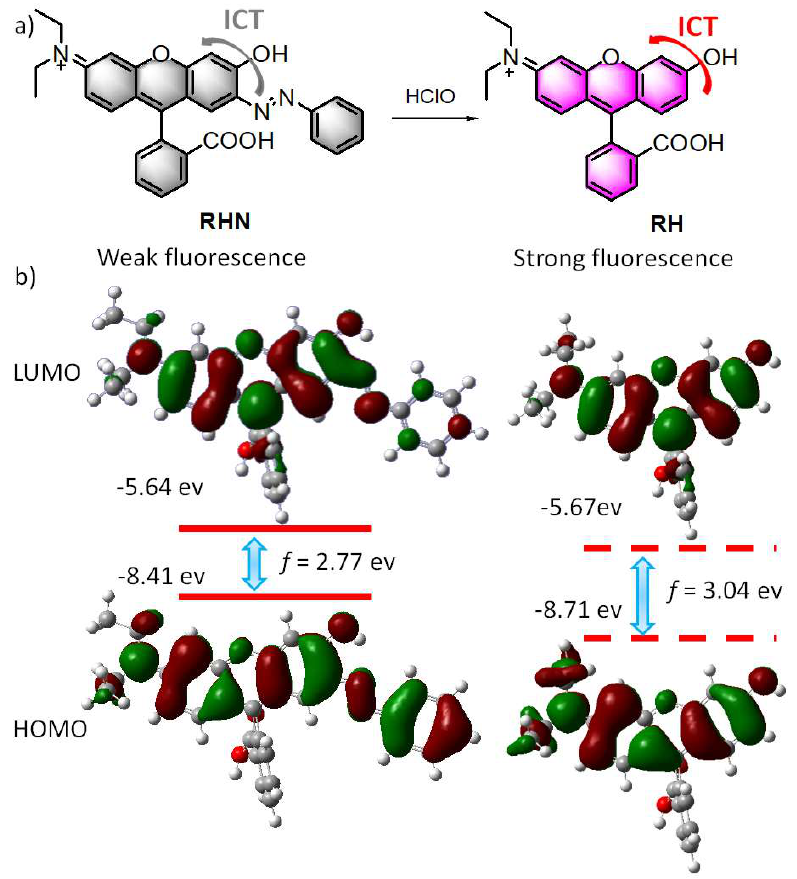
Scheme 2. ( a ) The possible reaction mechanism; ( b ) The LUMO and HOMO of RHN and RH cal- culated with DFT at the B3LYP/6-31G* level using Gaussian 09.